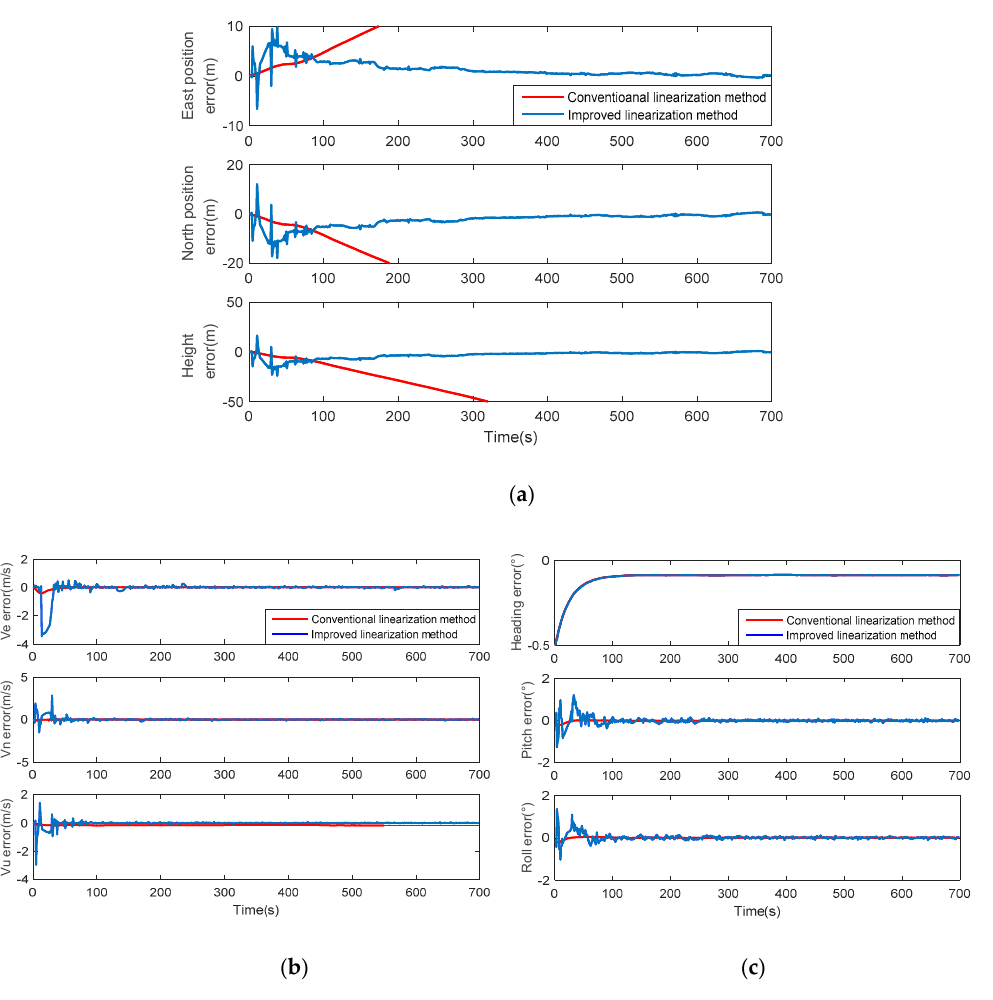
Figure 6. Comparison between conventional and improved linearization methods when tracking loop is stable. ( a ) Position errors; ( b ) velocity errors; ( c ) attitude errors.